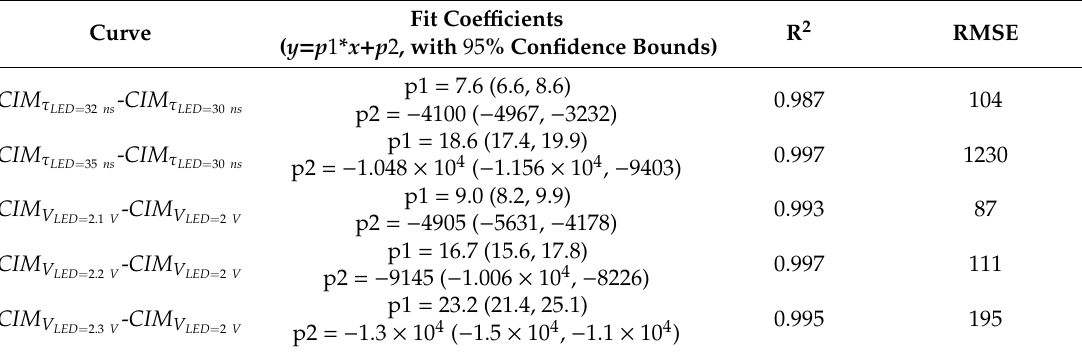
R 2 RMSE 0.987 104 0.997 1230 0.993 87